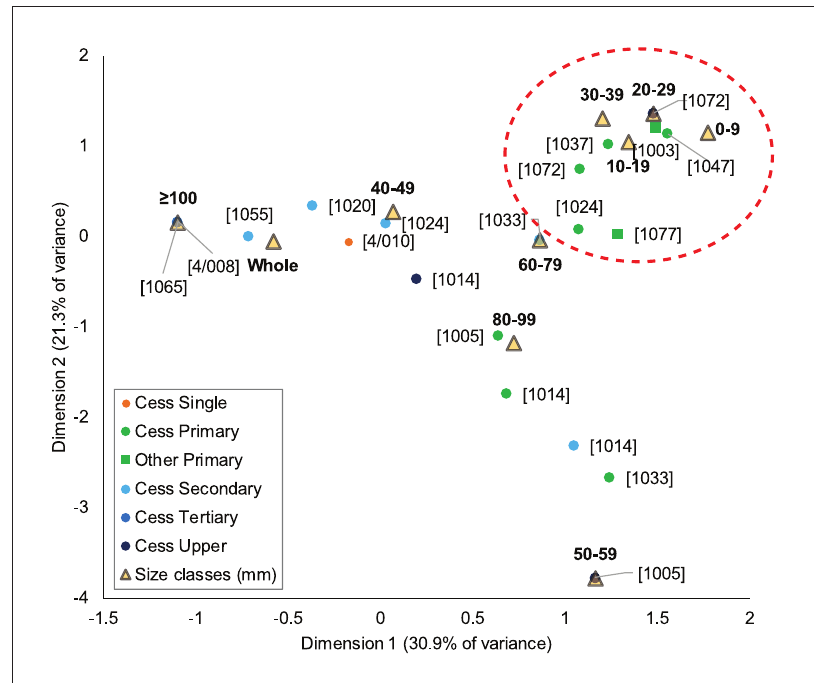
Figure 1: Correspondence analysis of the weight proportion in each size class (mm), with whole bones categorised separately. Figure: E. V.